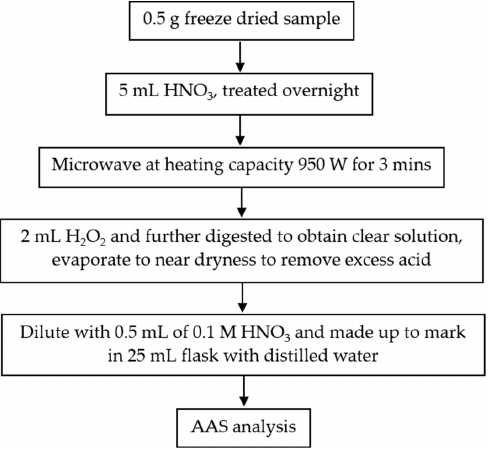
Figure 1. Experimental setup.